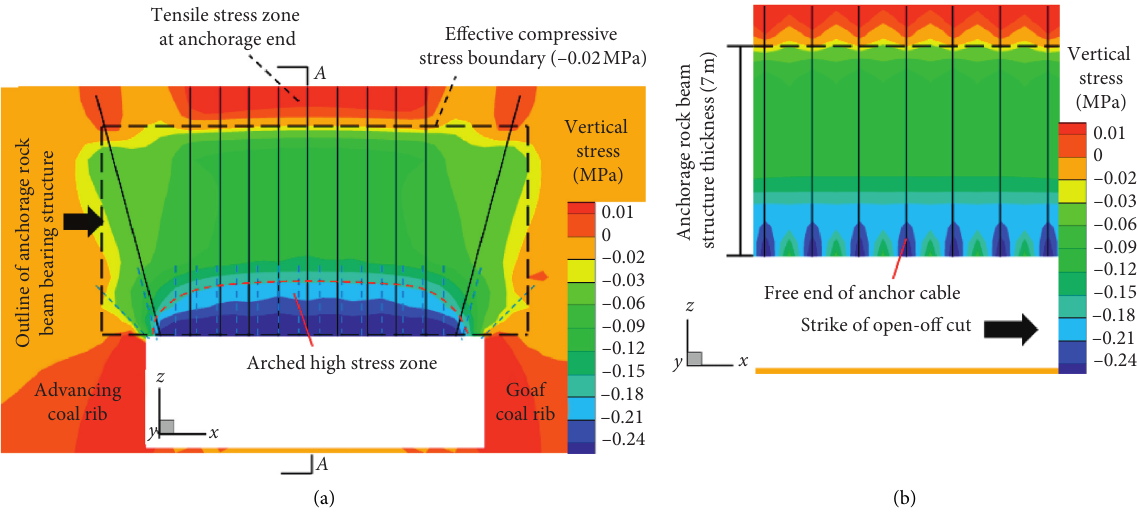
Figure 4: Prestressed stress distribution in open-off cut roof under the roof anchor bolts and anchor cables support. (a) Cross section. (b) Strike (cross section A-A in Figure